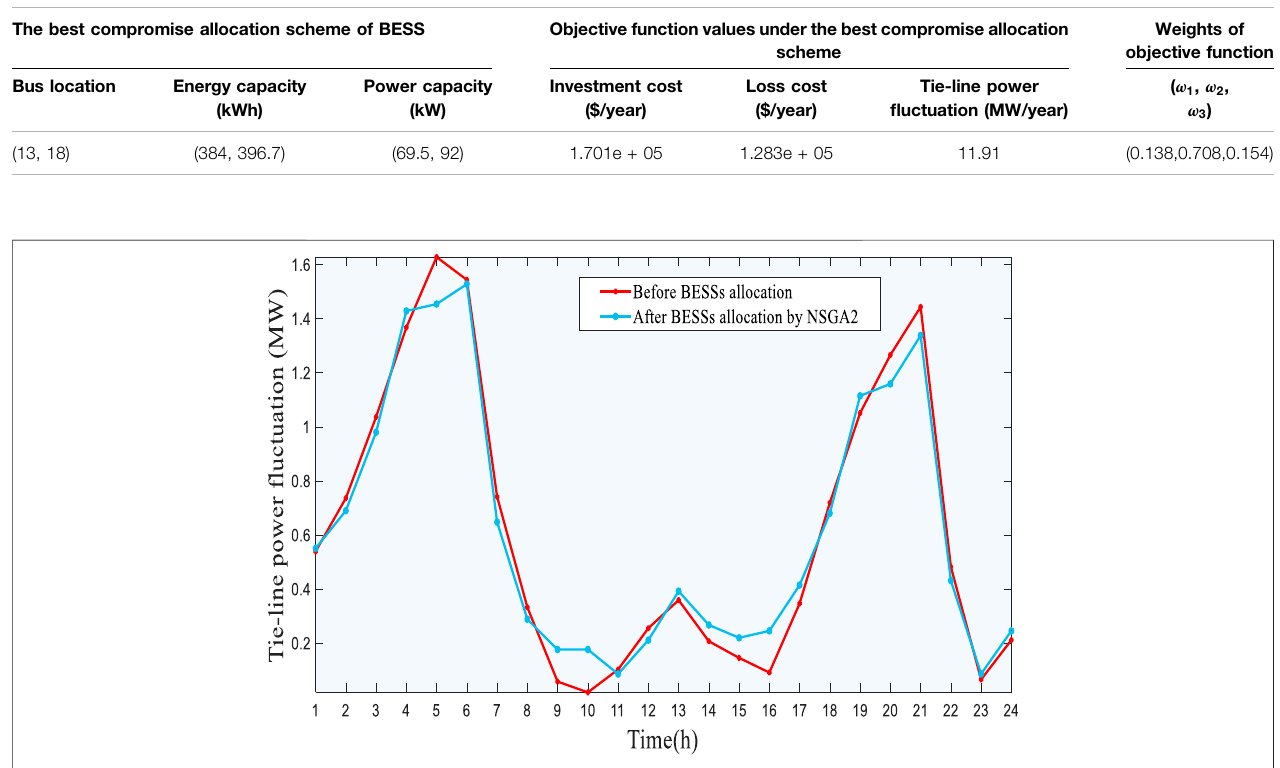
FIGURE 6 | Annual average load curve of the distribution network before and after BESS allocation.